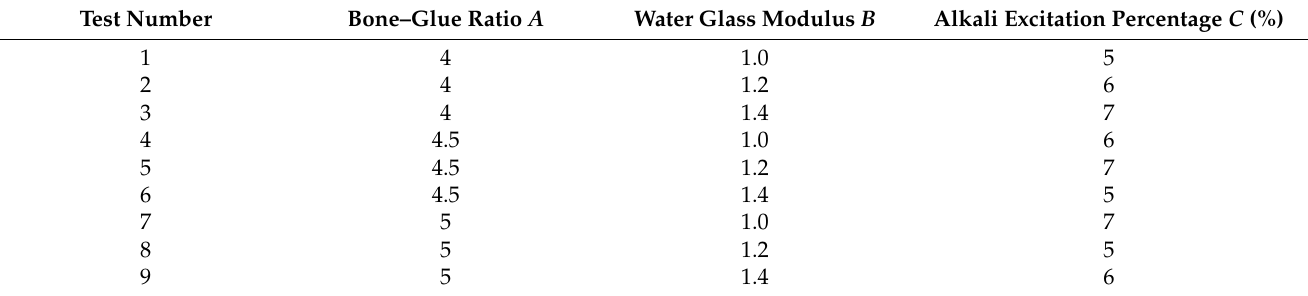
Table 4. Orthogonal mix proportion